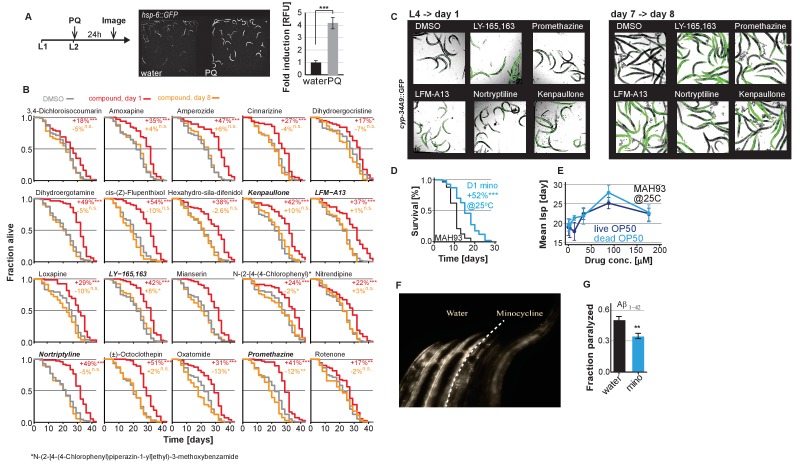
Small molecules screened for post-stress-responsive lifespan.(A) Positive control to demonstrate that the lack of hsp-6p::GFP activation in adult animals (Figure 1A,B) is due to age and not due to a defective strain. Experimental timeline, fluorescent images and bar graphs depicting paraquat-induced (PQ) expression of hsp-6p::GFP when added at the L2 larval stage. (B) Survival curves for the bar graphs shown in Figure 1C. Small molecules screened for lifespan extension when added on day 1 (red line) or day 8 (orange line) compared to untreated (gray line). Significance determined by the log-rank test. (C) Confirmation of drug uptake for a subset of drugs tested in Figure 1. Overlay of bright field and fluorescent images to monitor the xenobiotic reporter, cyp-34A9p::GFP activation. Small molecules that activate cyp-34A9p::GFP in day 1 animals also do so in day 8 animals as visualized by GFP expression confirming drug uptake at both ages. (D and E) Representative survival and dose response curves showing minocycline extends lifespan of MAH93 glp-1(ar202), a strain that is sterile at 25°C, in the absence of FUDR (D) and with or without γ-irradiated OP50 dose-dependently (E). (F) Side-by-side comparison of 8-day-old NL5901 α-synuclein::YFP animals treated on day 1 with water (left three animals) or minocycline (right three animals). (G) Graph shows fraction of paralyzed 4-day-old adult C. elegans animals expressing Aβ1-42 after a 1 hr heat shock at 35°C. Pretreatment with minocycline (100 μM) reduces paralysis. Asterisks indicate significance *<0.05, **<0.01, ***<0.001, n.s. not significant.